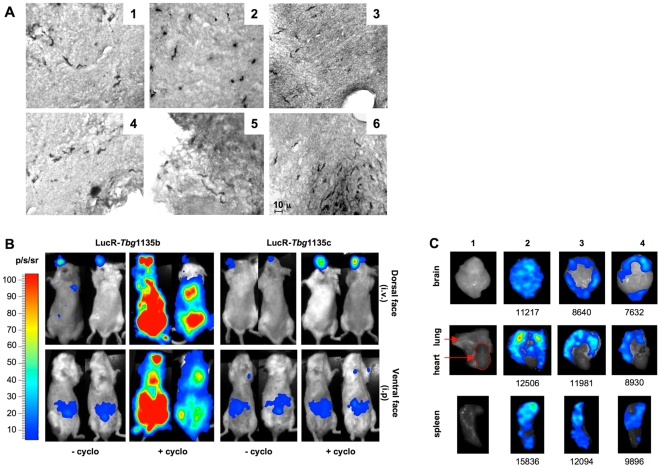
Analysis of T. b. gambiense organs and central nervous system invasion in BALB/c-infected mice.A. Immunohistochemical detection of trypanosomes in the brains of mice (n = 2, only results from one mouse are shown) infected for 4 months with 106 parasites of the Tbg945b isolate (1, 2, 3) and of paralyzed mice (n = 2) treated with cyclophosphamide before infection with either 5×106 parasites of subchronic Tbg1122c or Tbg1166c isolates. Paralysis occurred 10 and 6 months PI with Tbg1122c and Tbg1166c isolates respectively. Only results from Tbg1122c are shown (4, 5, 6). A1 and A4 correspond to an olfactory bulb coronal section, A2 to a forebrain section, A3 and A5 to brain stem sections and A6 to a cerebellum section. Whole brain invasion was observed with the chronic isolate at an advanced stage of the disease (4 months PI, death within 6–8 months). Invasion was restricted to the olfactory bulb and the brain stem (including the cerebellum for Tbg1122c) in paralyzed mice infected with the sub-chronic isolates after treatment with cyclophosphamide. No invasion was observed in mice (n = 2) infected for 9 months with 5×106 parasites of subchronic Tbg1166c isolate (data not shown). B. Spatial distribution of R-Luc activity in animals developing a sub-chronic or a silent infection and treated with or without cyclophosphamide (+/−cyclo). BALB/c mice were either directly infected with 106 LucR-Tbg1135b (n = 6) or LucR-Tbg1135c (n = 2) or treated 24 h before infection with cyclophosphamide (n = 2). At different time PI, mice were anaesthetized and injected intravenously (i.v., retro-orbital) or intraperitoneally (i.p.) with coelenterazine and BLI signals were recorded in real time with a Biospace Imaging System. The panels show dorsal and ventral images of 2 representative mice infected for 8–11 weeks: LucR-Tbg1135b (11 weeks), LucR-Tbg1135c (10 weeks), LucR-Tbg1135b+cyclo (9 weeks), LucR-Tbg1135+cyclo (8 weeks). C. Spatial distribution of R-Luc activity in organs removed from LucR-Tbg1135 infected BALB/c mice. The different organs shown in this figure were isolated from mice: (1) non infected (control) (2) infected for 18 weeks with 106 LucR-Tbg1135b, (3) infected for 18 weeks with 106 LucR-Tbg1135c, (4) pre-treated with cyclophosphamide and infected for 16 weeks with 106 LucR-Tbg1135c. Quantification data of light emission signals for ROI delimitating each organ are given in photons/second/cm2/steradian (p/sec/cm2/sr).